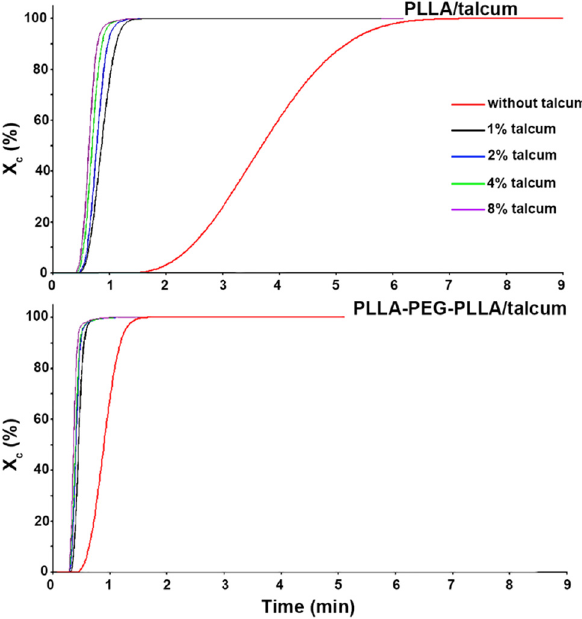
Figure 4: Relative crystallinity ( X c ) as a function of time for ( above ) PLLA/talcum and ( below ) PLLA - PEG - PLLA/talcum composites for various talcum